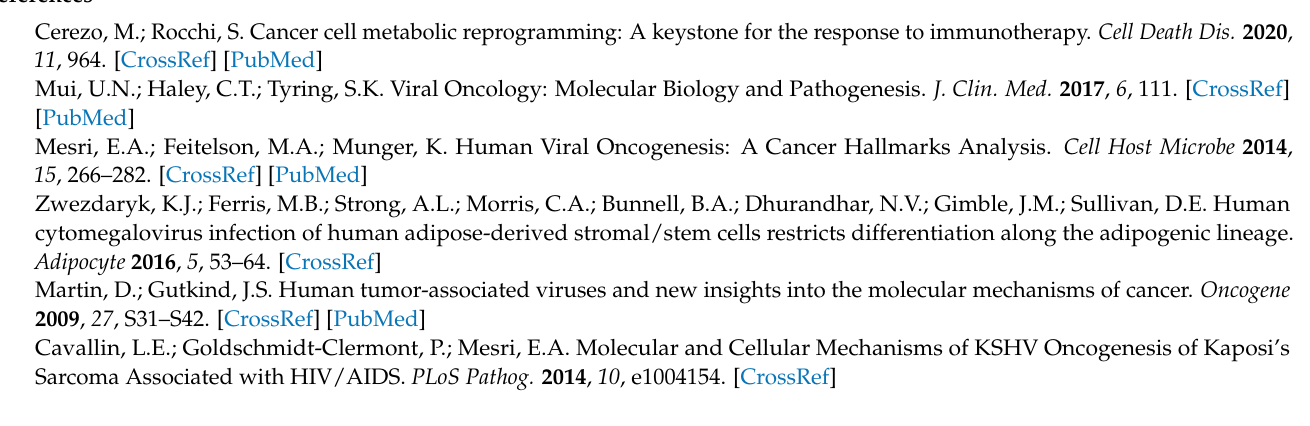
Figure S2: Crystal violet assay for cell